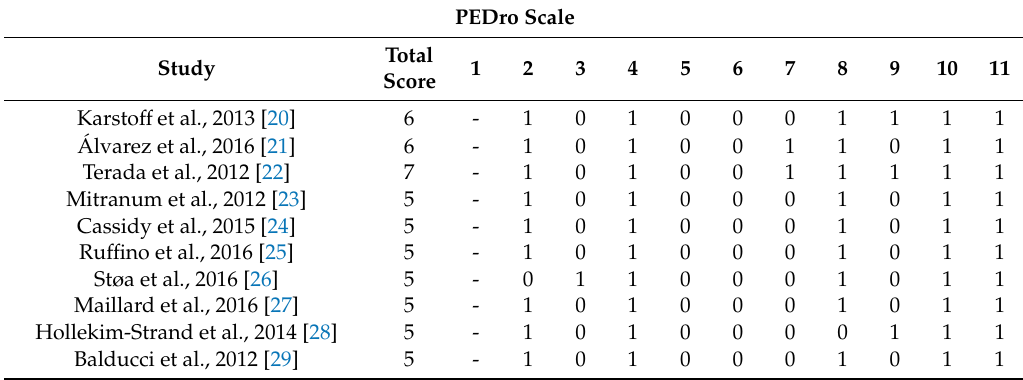
Table 1. Physiotherapy Evidence Database (PEDro) scale score for clinical trials included in the